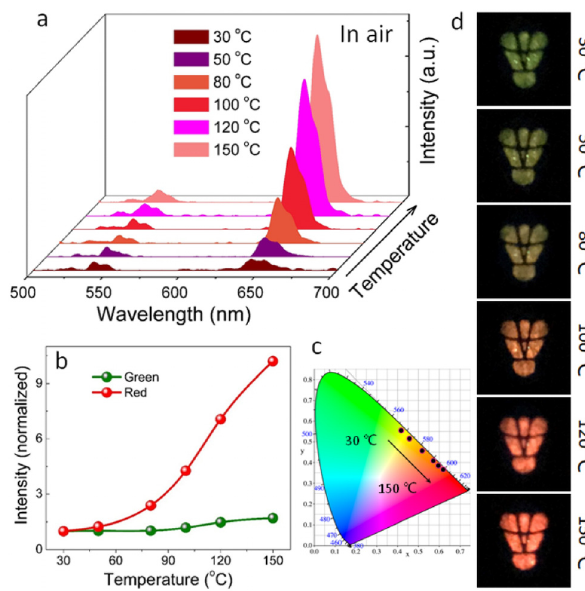
Figure 2: (a) Temperature-dependent UCL spectra of β -NaGdF 4 :30% Ce/20%Yb/2%Honanocrystalsin air (power density: 1.6 W/cm 2 ). (b) Integrated UCL intensities of red and green bands, noting that the intensities are normalized to that at 30 ° C. (c) Temperature- dependent color coordinates of nanocrystals in CIE chromaticity diagram. (d) Temperature-induced color shifts of patterns printed with nanocrystal